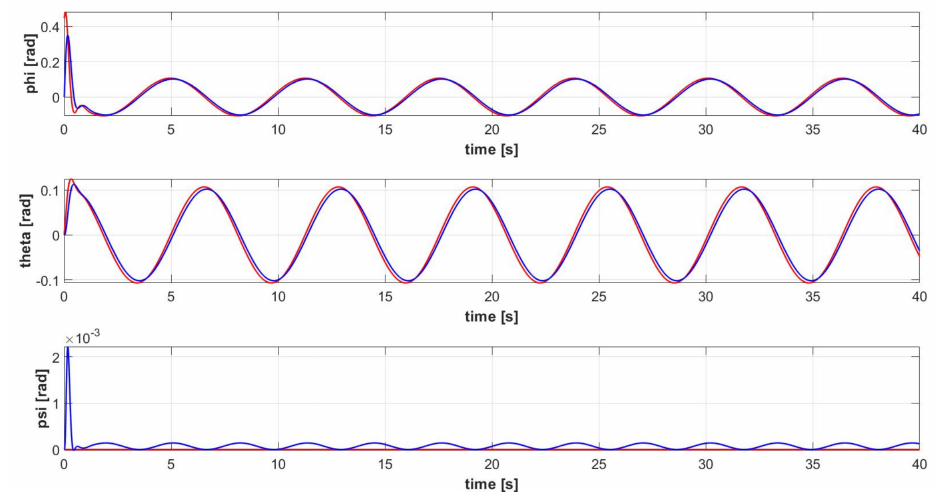
Figure 12. Euler angles signals [ φ ( t ) , ϑ ( t ) , ψ ( t ) ] of the controlled quadrotor system (blue) and reference attitude signals for trajectory 1 (red).